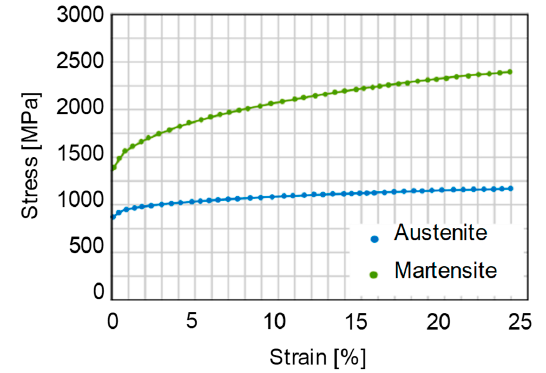
Figure 7. Flow stress curves of austenite and martensite phase.